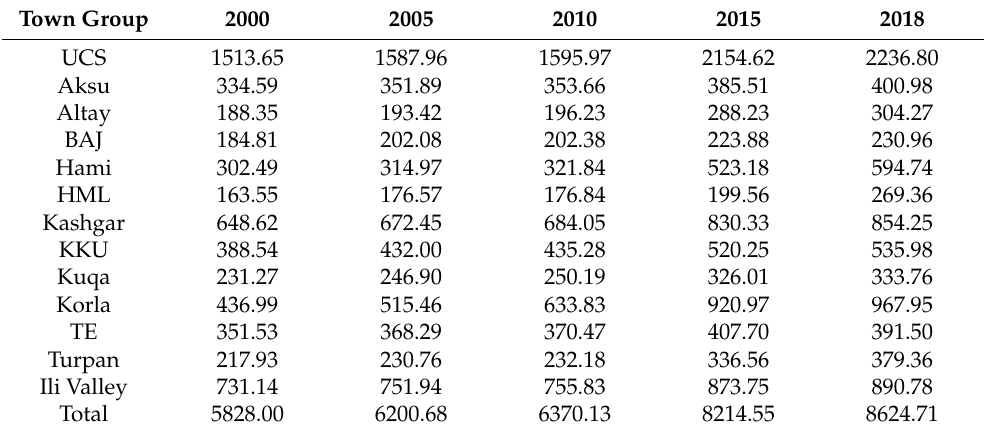
Table 3. Changes in construction land area in the town groups from 2000 to 2018 unit: km 2 .